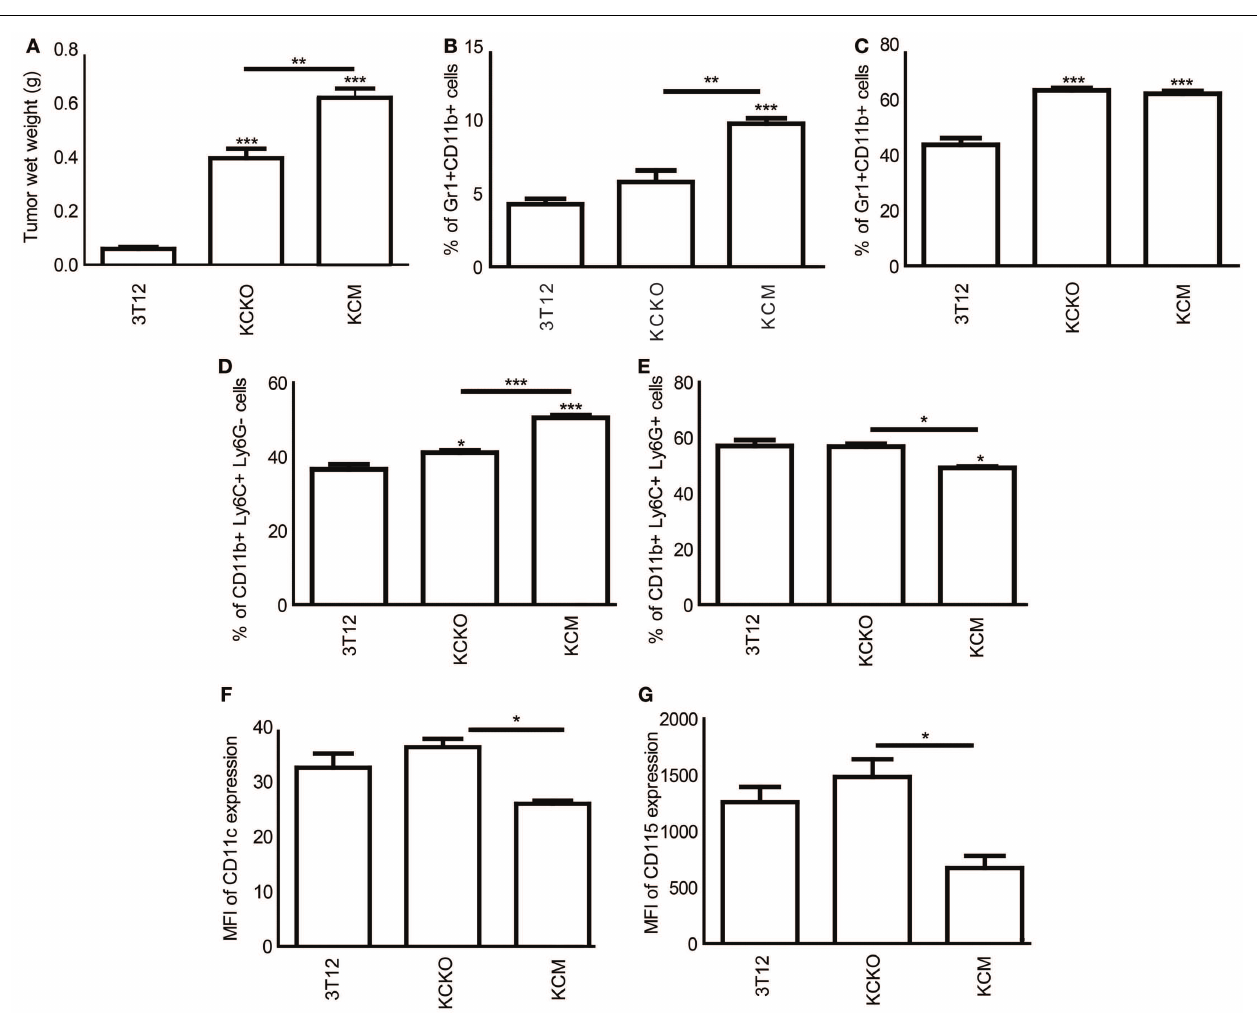
Gr1 + CD11b + cells in the bone marrow (D,E) Percentage of MDSC subsets (CD11b + Ly6C + LyG − and CD11b + Ly6C + Ly6G + ) in the bone marrow; (F,G) CD11c and CD115 expression analyzed on CD11b + gated cells from bone marrow expressed in terms of MFI. Percentages are not absolute numbers. Mean and standard error are plotted. * p < 0.05, ** p < 0.01, and *** p < 0.001 for statistically significant differences from control (3T12) levels unless indicated by line above the